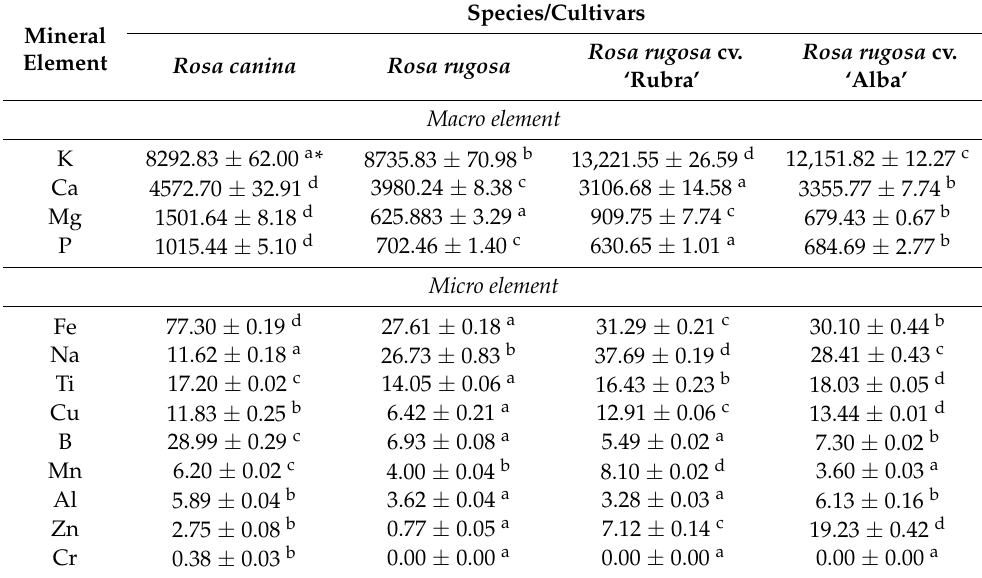
Table 3. Mineral content (mg kg − 1 DW) of different rosehip species/cultivar fruits (average